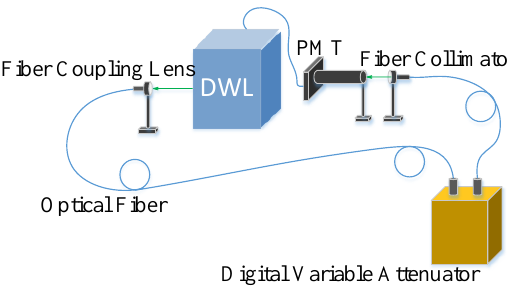
Figure 5. Diagram of the after-pulse count calibration system (APCCS).